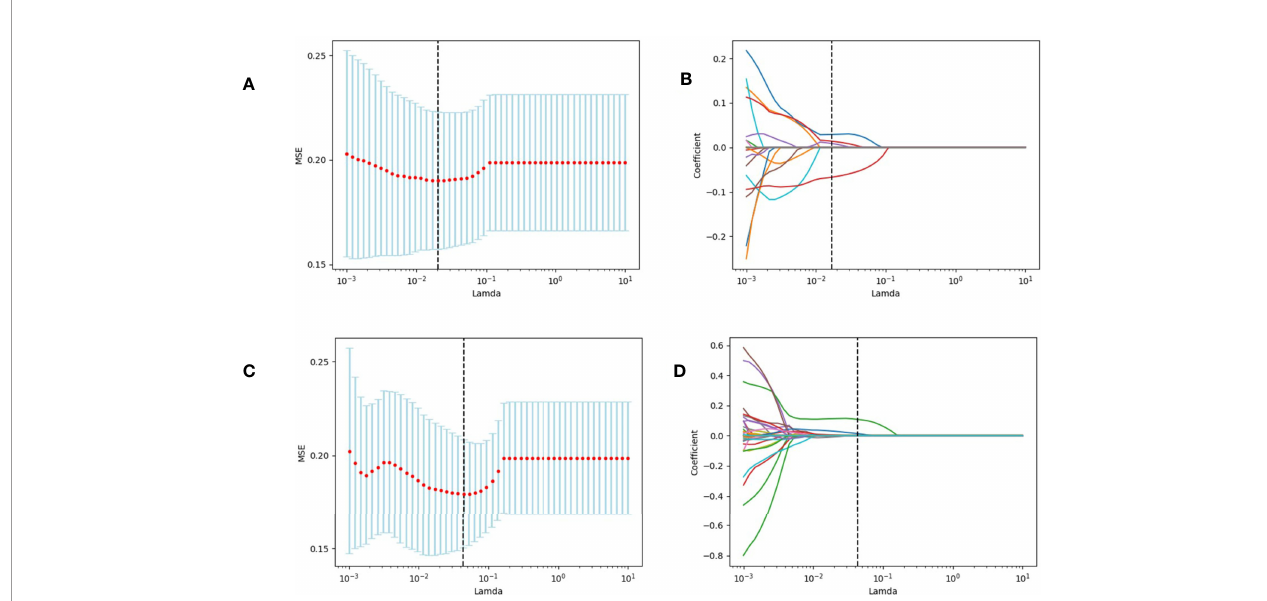
FIGURE 2 | We used two feature selection methods, maximum relevancy and minimum redundancy (MRMR) and the LASSO to select the radiomic feature of CT and PET. At fi rst, MRMR was performed to eliminate the redundant and irrelevant features. Then LASSO was conducted to choose the optimized subset of features to construct the fi nal model. (A, C) Tuning parameter Lambda ( l ) selection in the LASSO model used 10-fold cross-validation via minimum criteria. (B, D) LASSO coef fi cient pro fi les of the retained features. A vertical line was drawn at the value selected using 10-fold